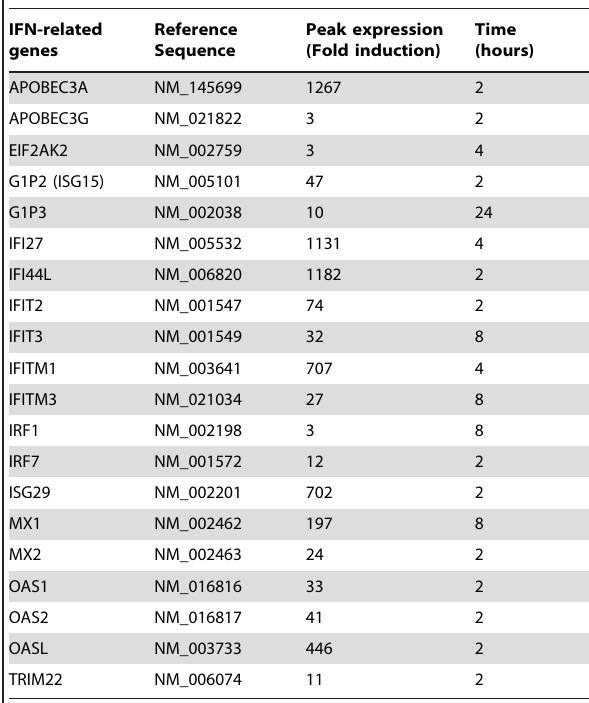
Table 2. Peak expression and time point of known genes associated in IFN response that were modulated in IFN a 2 pre-treated macrophages compared to untreated